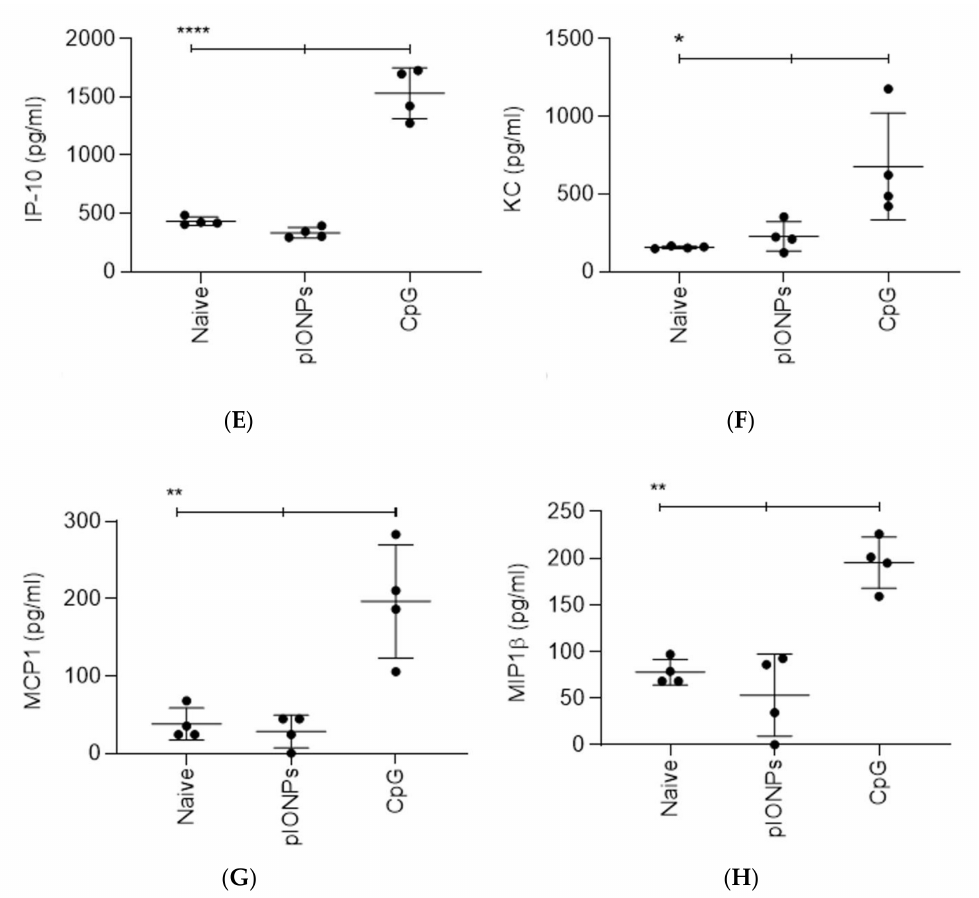
Figure 4. Cytokine responses measured by multiplex assay in sera 48 h after injection of pIONPs. Mice were immunized with pIONPs (1% solids in 100 µ L per mouse), CpG (25 µ g in 100 µ L per mouse) or saline controls (Naïve) intradermally at the base of tail. After 48 h, cardiac serum was harvested and run on a multiplex assay. ( A ) IL-6, ( B ) TNF α , ( C ) IL-10, ( D ) G-CSF, ( E ) IP-10, ( F ) KC, ( G ) MCP-1 and ( H ) MIP-1 β . Standards were fit with a five-parameter logistic model and experimental data were interpolated. Individual mice are plotted with mean +/ - SD ( n = 4). All stats were completed using a one-way ANOVA with Tukey’s multiple comparison test. * p < 0.05, ** p < 0.01, *** p < 0.001, **** p <